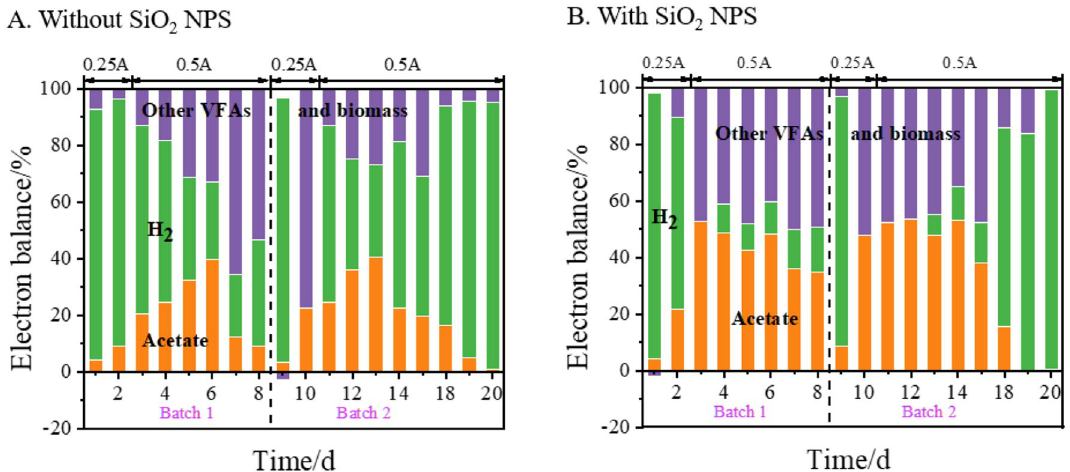
Fig. 5 The electron balance of the MES reactor in two batches